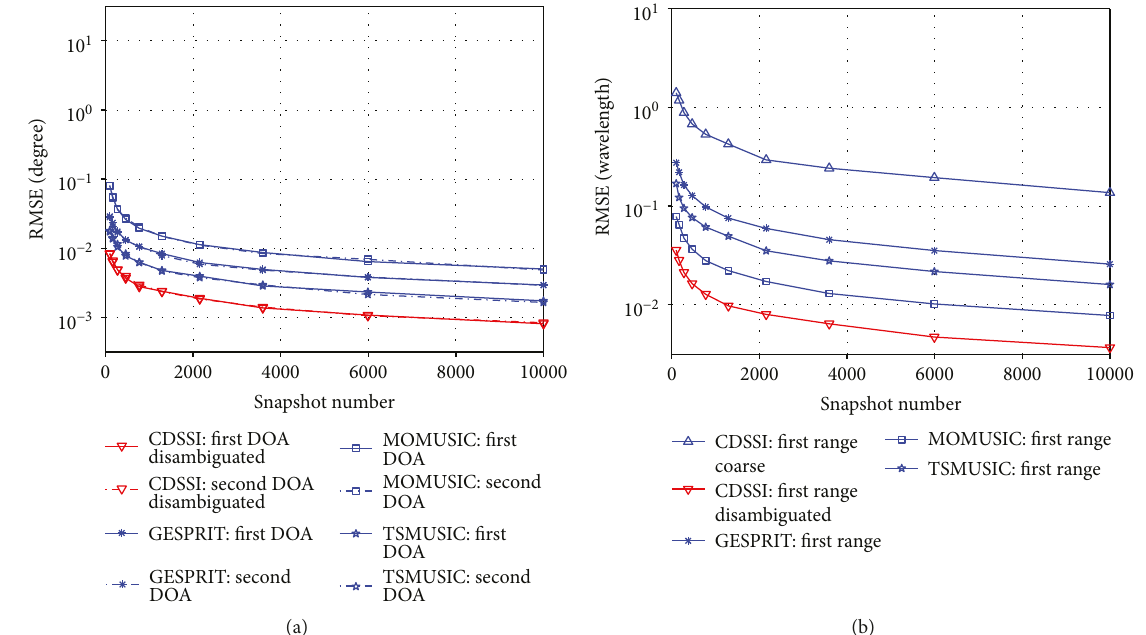
Figure 9: RMSEs of DOA and range estimates versus snapshot number.